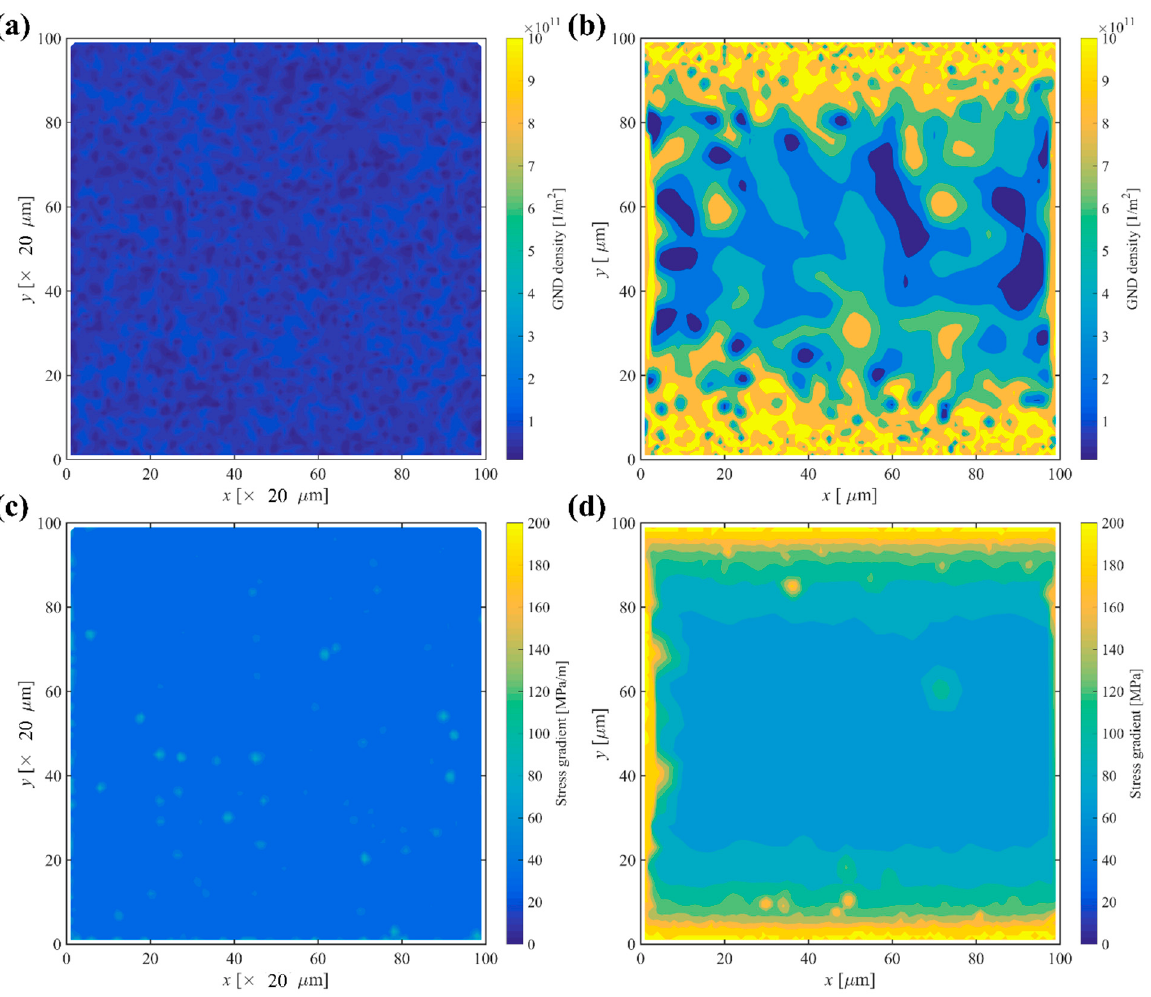
Figure 8. GND density in ( a ) homogenous structures and ( b ) gradient structures. Stress gradient in ( c ) homogenous structures and ( d ) gradient structures. The results are recorded on IF steel specimens at 5% strain.